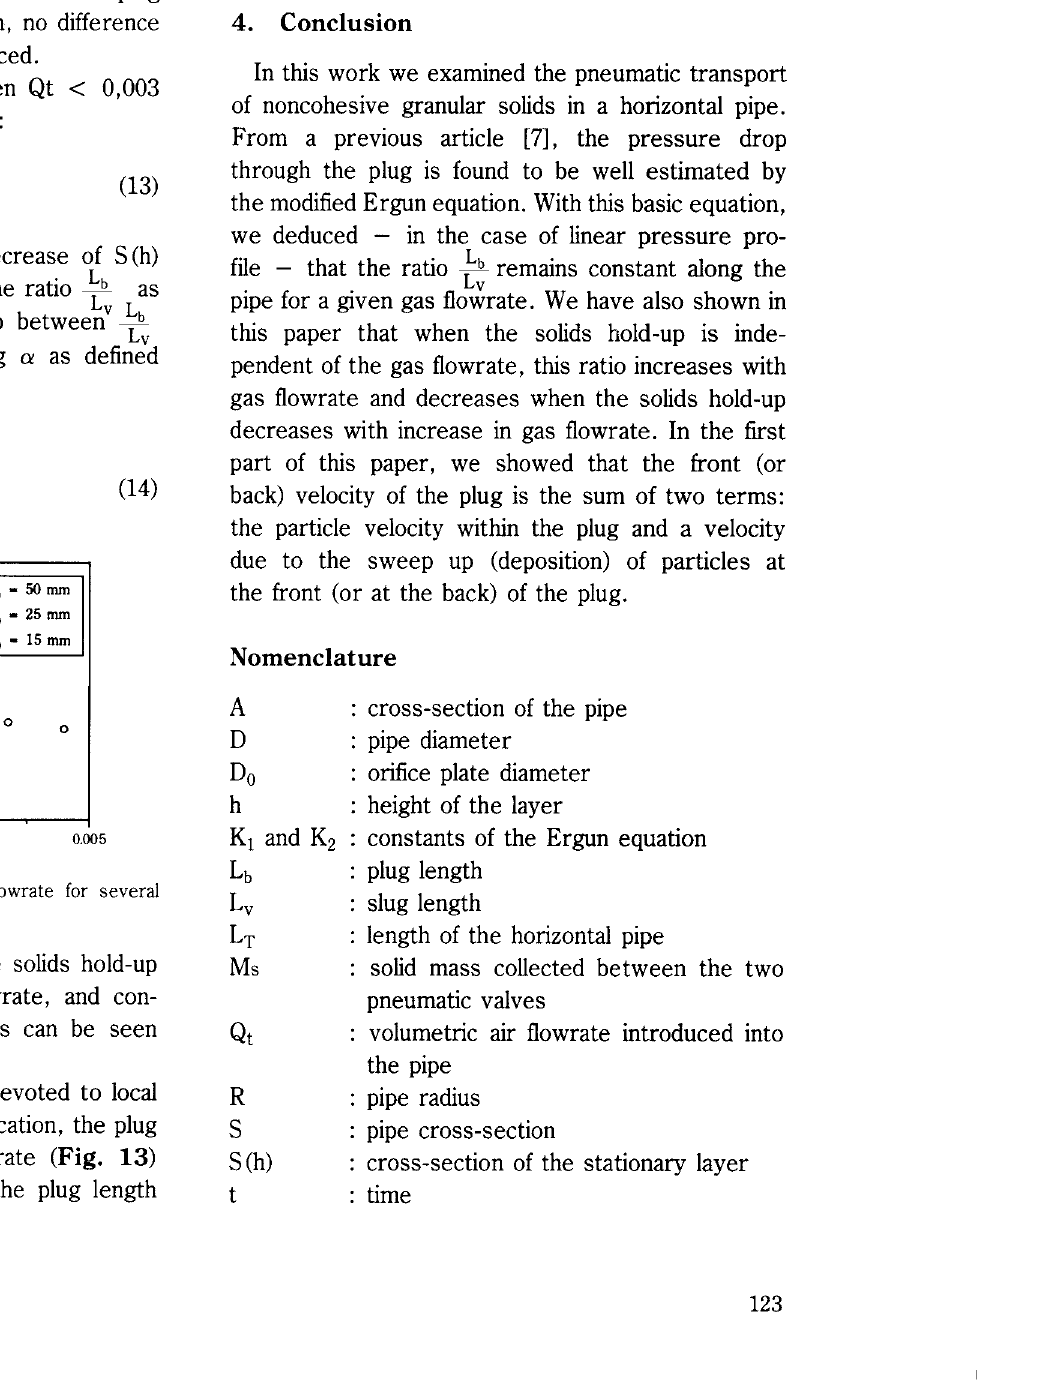
Fig. 13 Variation of plug length with gas flowrate. Measure ments at location A (Fig. 1) 4 m after the elbow increases along the